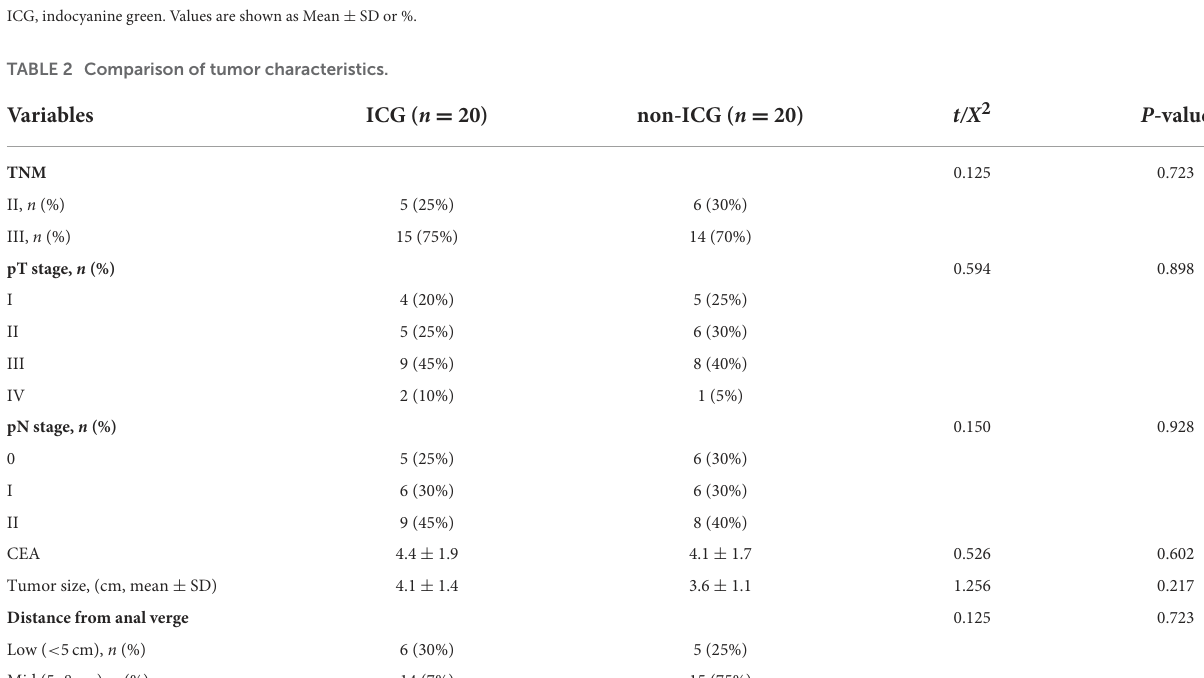
TABLE 2 Comparison of tumor